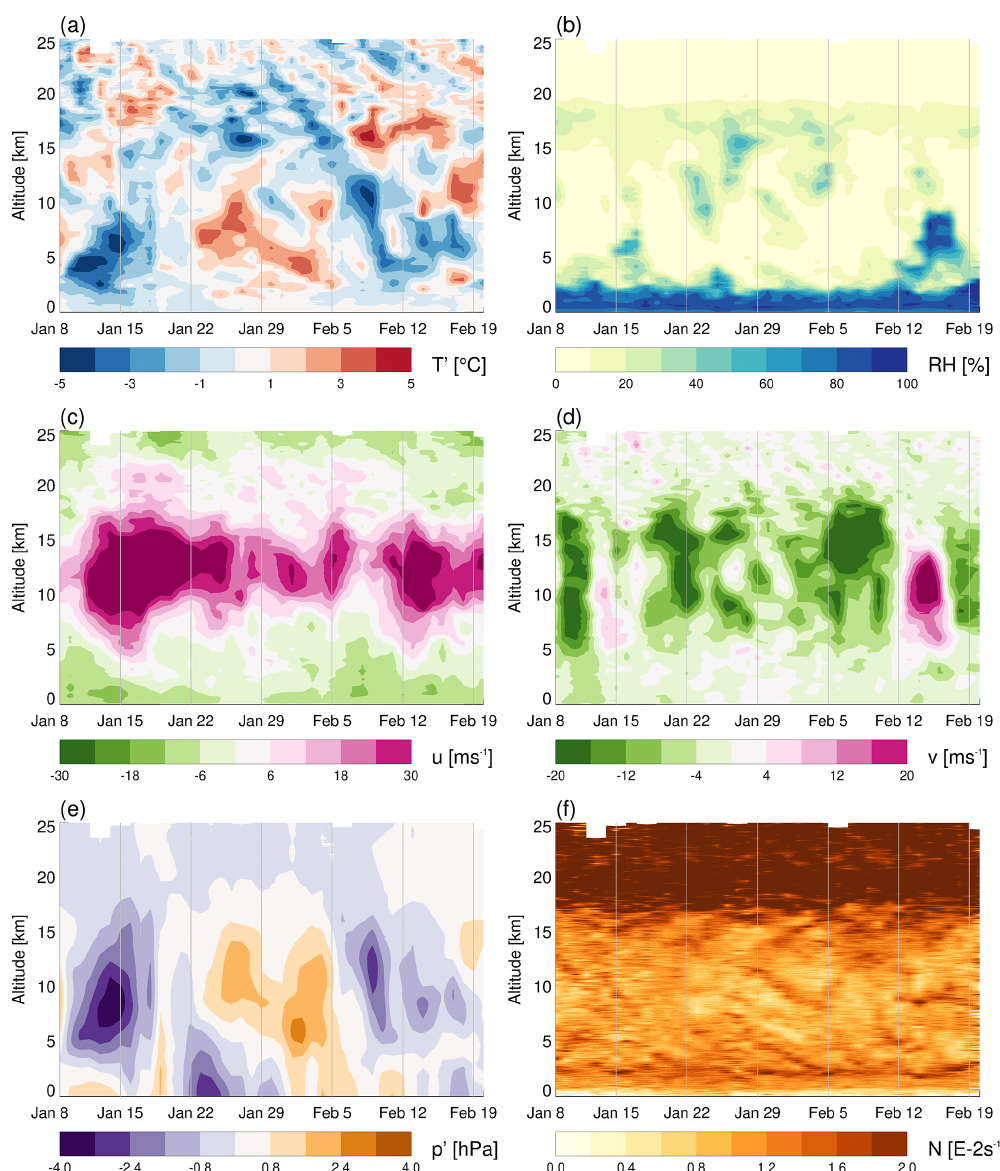
Figure 11. (a–e) Time–height cross sections of daily (a) temperature anomaly, (b) relative humidity, (c) zonal wind, (d) meridional wind, (e) pressure anomaly, and (f) Brunt–Väisälä frequency (units of 10 − 2 s − 1 ), computed from ascending soundings north of 12.5 ◦ N. The data combine 182 soundings from the BCO, 169 from Brown , 159 from Meteor , 30 from Merian , and 4 from Atalante . Anomalies are defined as deviations from the time average at each